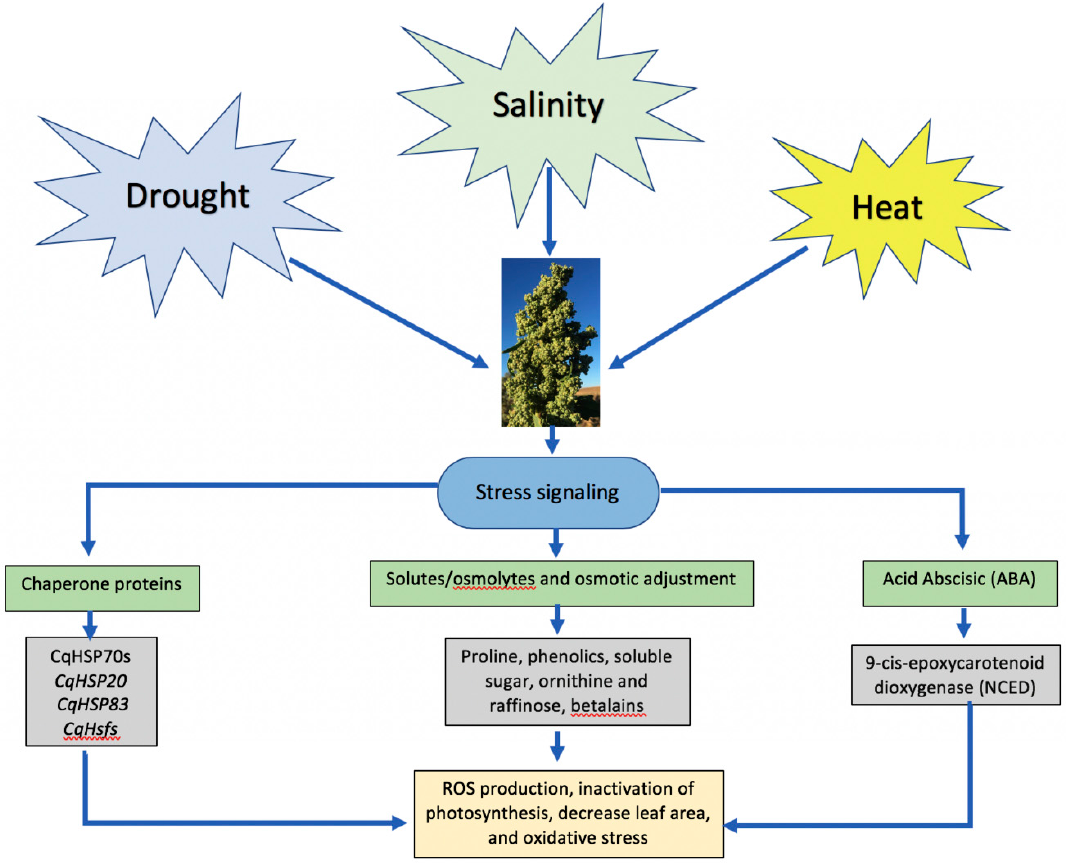
Figure 3. Primary physiological responses to drought, heat, and salinity on quinoa. The expression of NCED genes is upregulated to drought and salinity and chaperone proteins are upregulated to drought and heat stress.